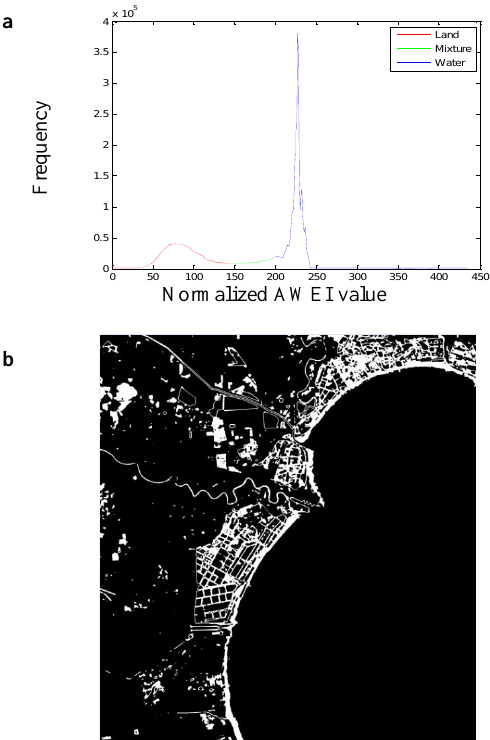
Figure 1 . a) The histogram of normalized AWEI with the image in 1986. b) The mixture part with white part.